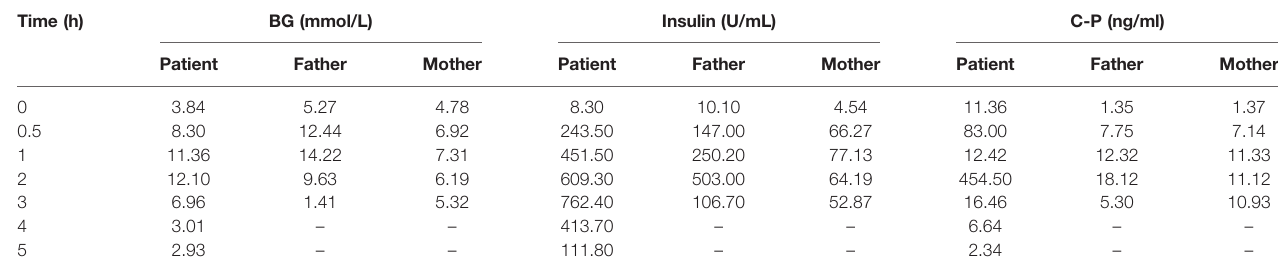
TABLE 1 | Results of the parental OGTT for patient and parents.